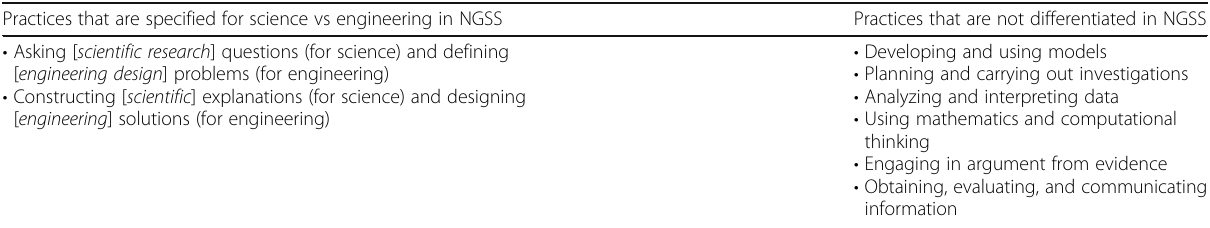
Table 1 Science and engineering practices outlined in NGSS (Achieve, 2013) Practices that are specified for science vs engineering in NGSS Practices that are not differentiated in NGSS (cid:129) Asking [ scientific research ] questions (for science) and defining [ engineering design ] problems (for engineering) (cid:129) Constructing [ scientific ] explanations (for science) and designing [ engineering ] solutions (for engineering)